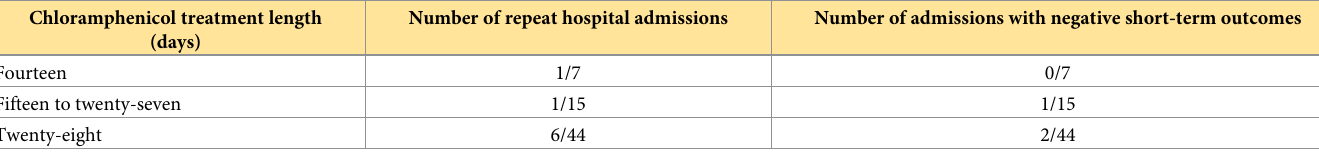
Table 2. Outcomes for varying treatment lengths of daily subcutaneous chloramphenicol injections at Endeavour Veterinary Ecology during the koala management program. Chloramphenicol treatment length